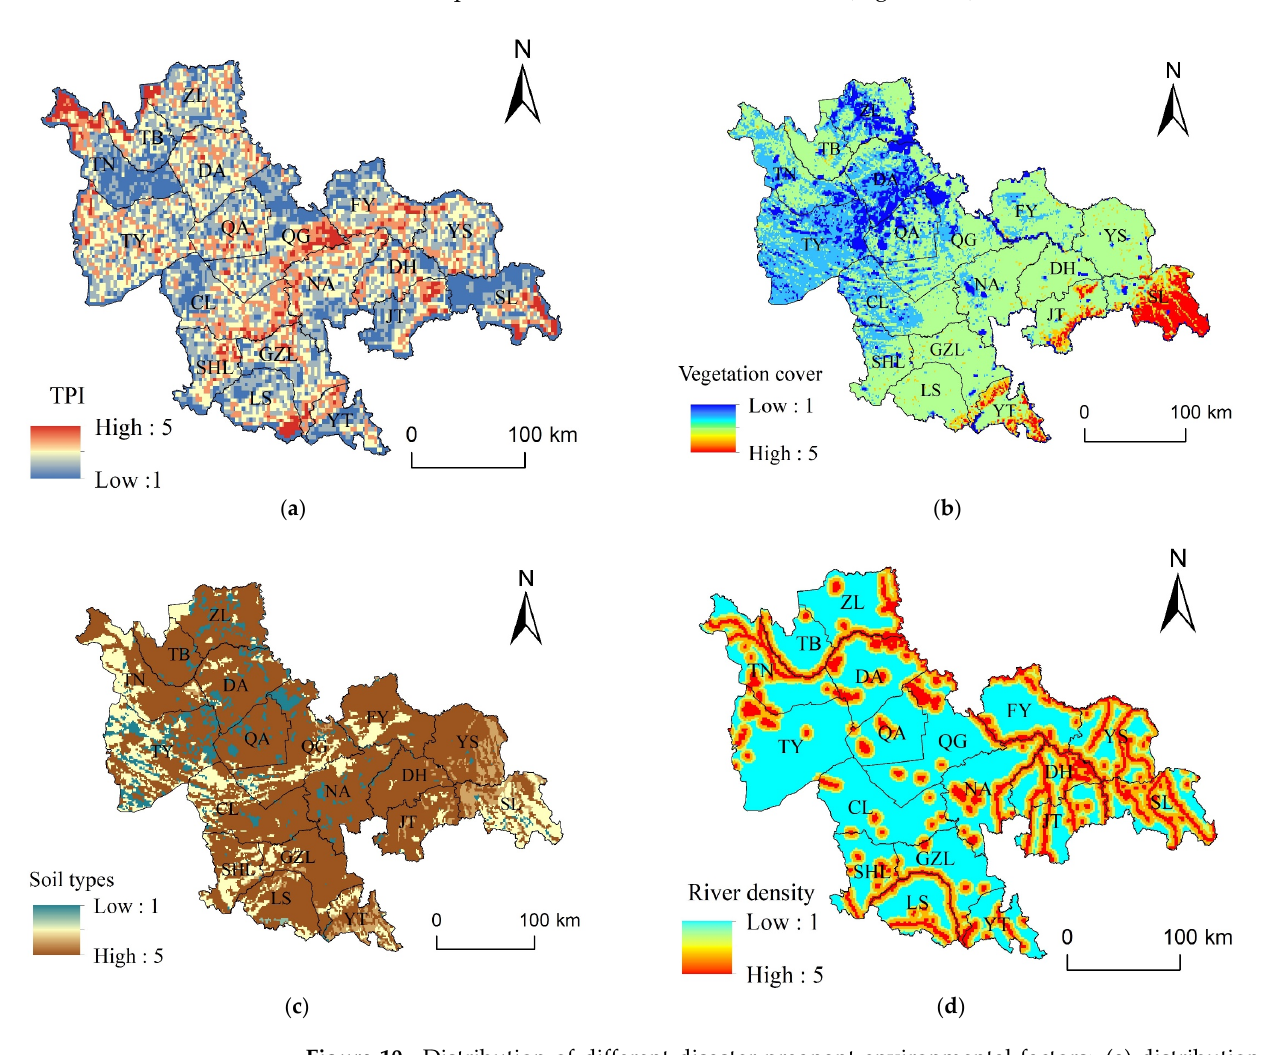
Figure 10. Distribution of different disaster-pregnant environmental factors: ( a ) distribution of topographic position index (TPI) levels; ( b ) distribution of vegetation cover levels; ( c ) distribution of soil types levels; ( d ) distribution of river density levels.